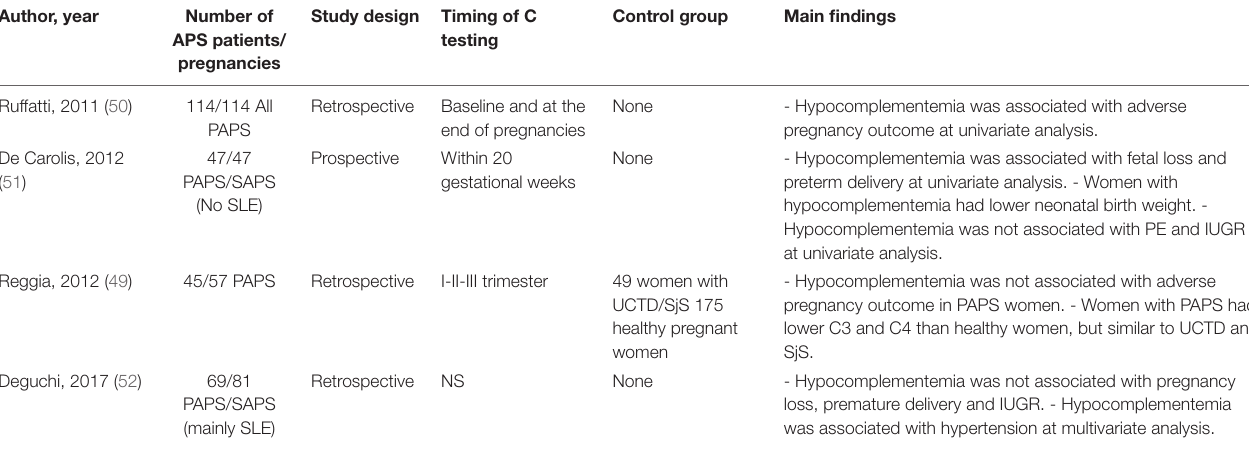
TABLE 1 | Studies assessing the correlation of C3 and C4 serum levels with obstetric outcome in pregnant women with anti-phospholipid